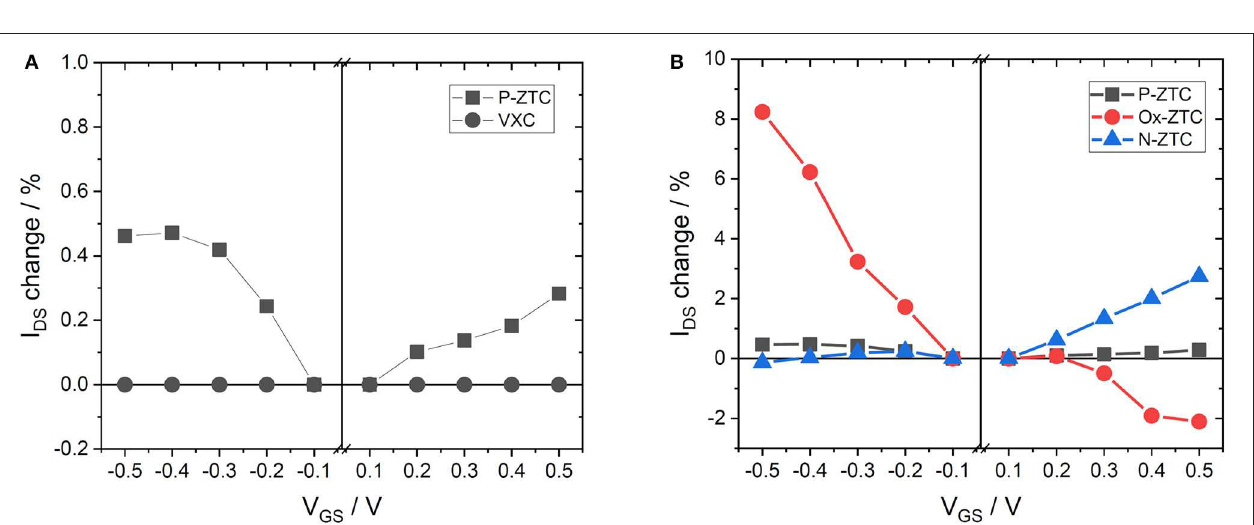
FIGURE 3 | ISFET characteristic curve of (A) P-ZTC and VXC and (B) Ox-ZTC and